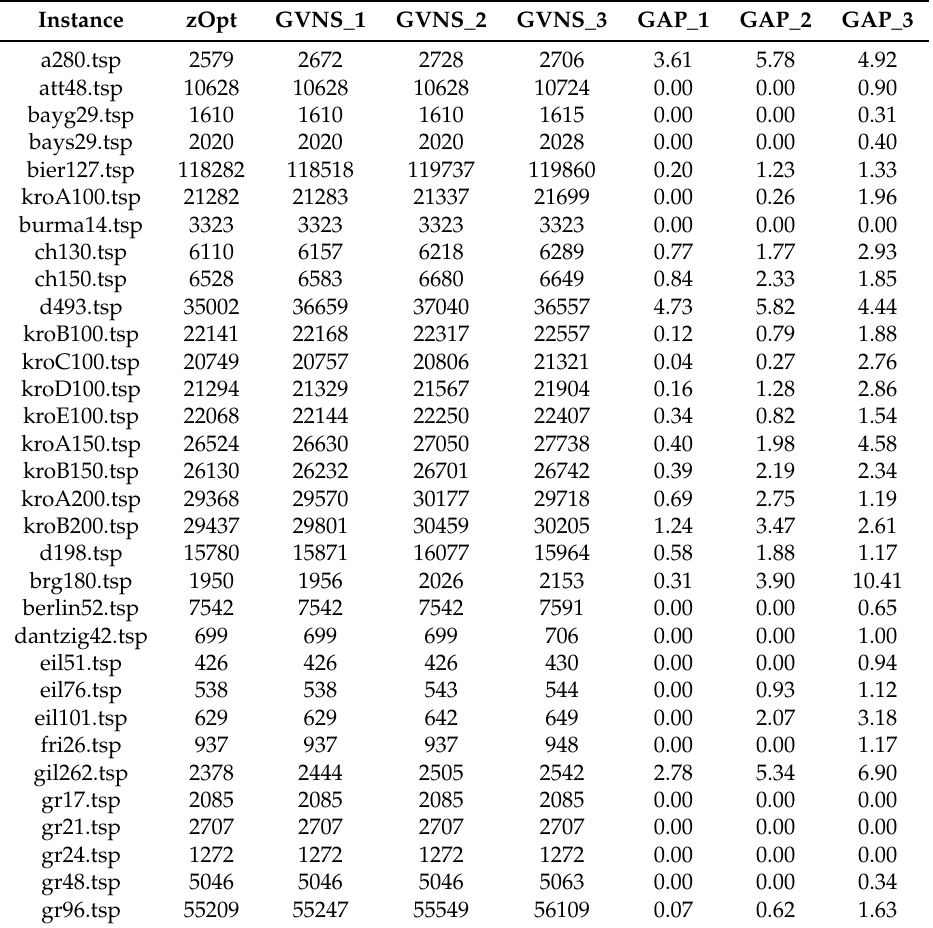
Table 7. Results using the First Improvement search strategy and an execution time limit of 2